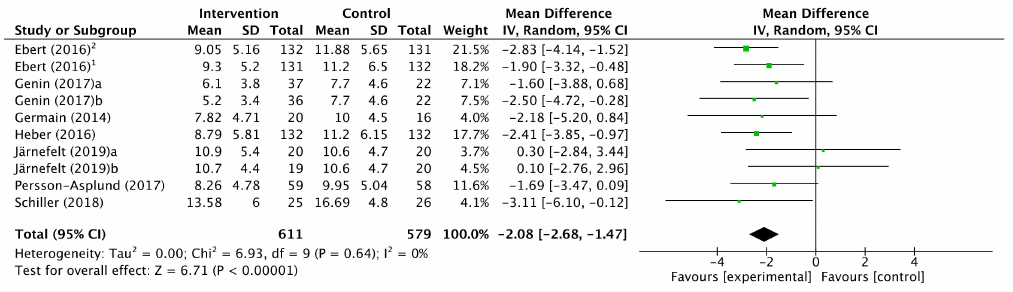
Figure 3. Forest plot of the e ff ectiveness of workplace interventions for the reduction of insomnia symptoms according to the Insomnia Severity Index after removing studies for their